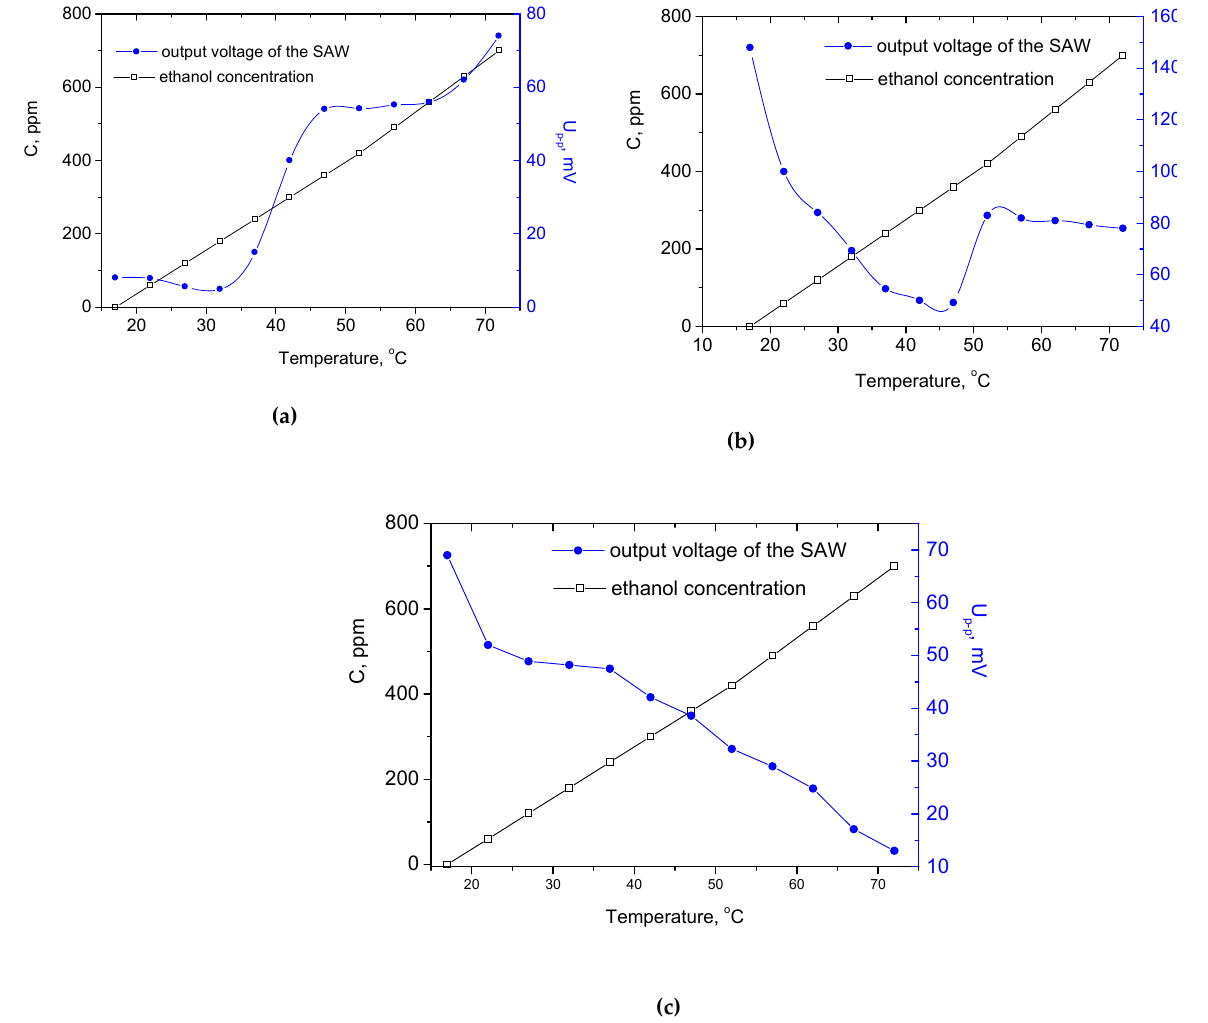
Figure 4. Peak-to-peak voltage of the sensors’ outputs at different temperatures in the chamber, corresponding to different evaporated concentrations of ethanol in its volume: ( a ) device 1, ( b ) device 2, and ( c ) device 3